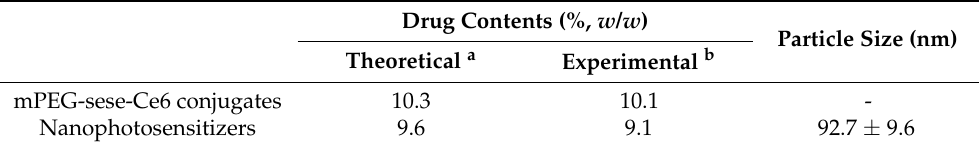
Figure 2. Chemical structure, synthesis scheme and 1 H NMR spectra of PBAP ( a ) and mPEGseseCe6PBAP conjugates ( b ).